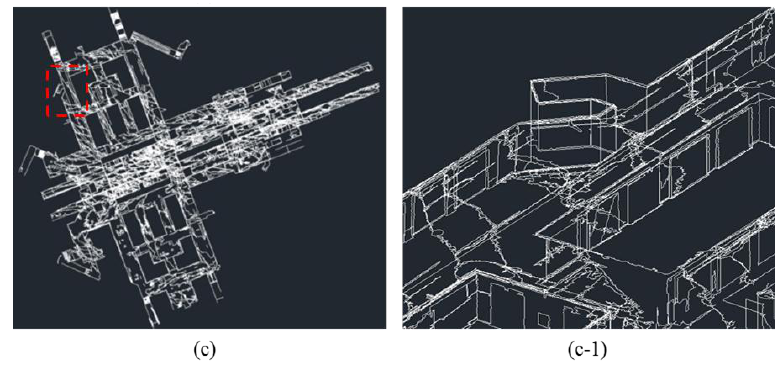
Figure 4. The result of each step in the processing: ( a ) Scanned point cloud; ( a-1 ) Detailed description of ( a ); ( b ) Segmented planes; ( b-1 ) Detailed description of ( b ); and ( c ) Geometric modeling; ( c-1 ) Detailed description of ( c